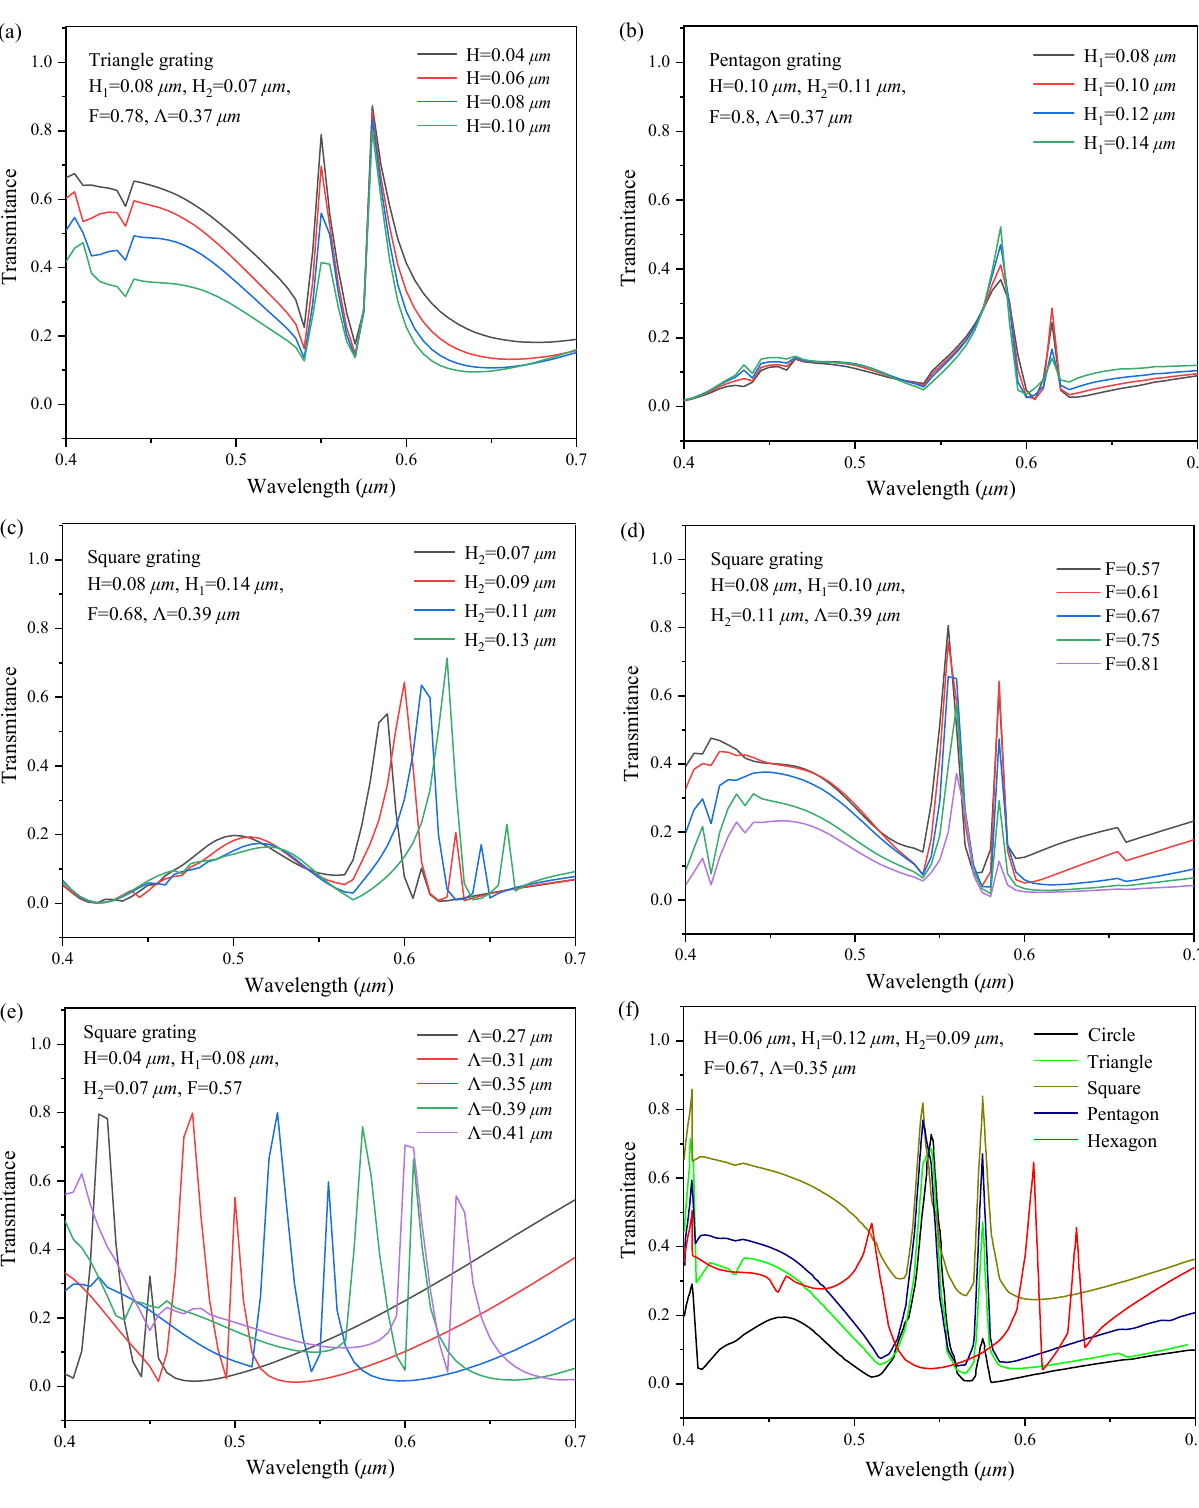
As a discontinuous classification value, the shape features of the two-dimensional